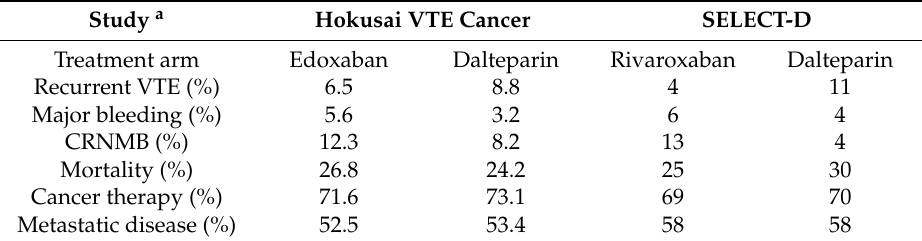
Table 2. Summary of randomized trials comparing DOACs with LMWH [7,8]. Study a Hokusai VTE Cancer SELECT-D Treatment arm Edoxaban Dalteparin Rivaroxaban Dalteparin Recurrent VTE